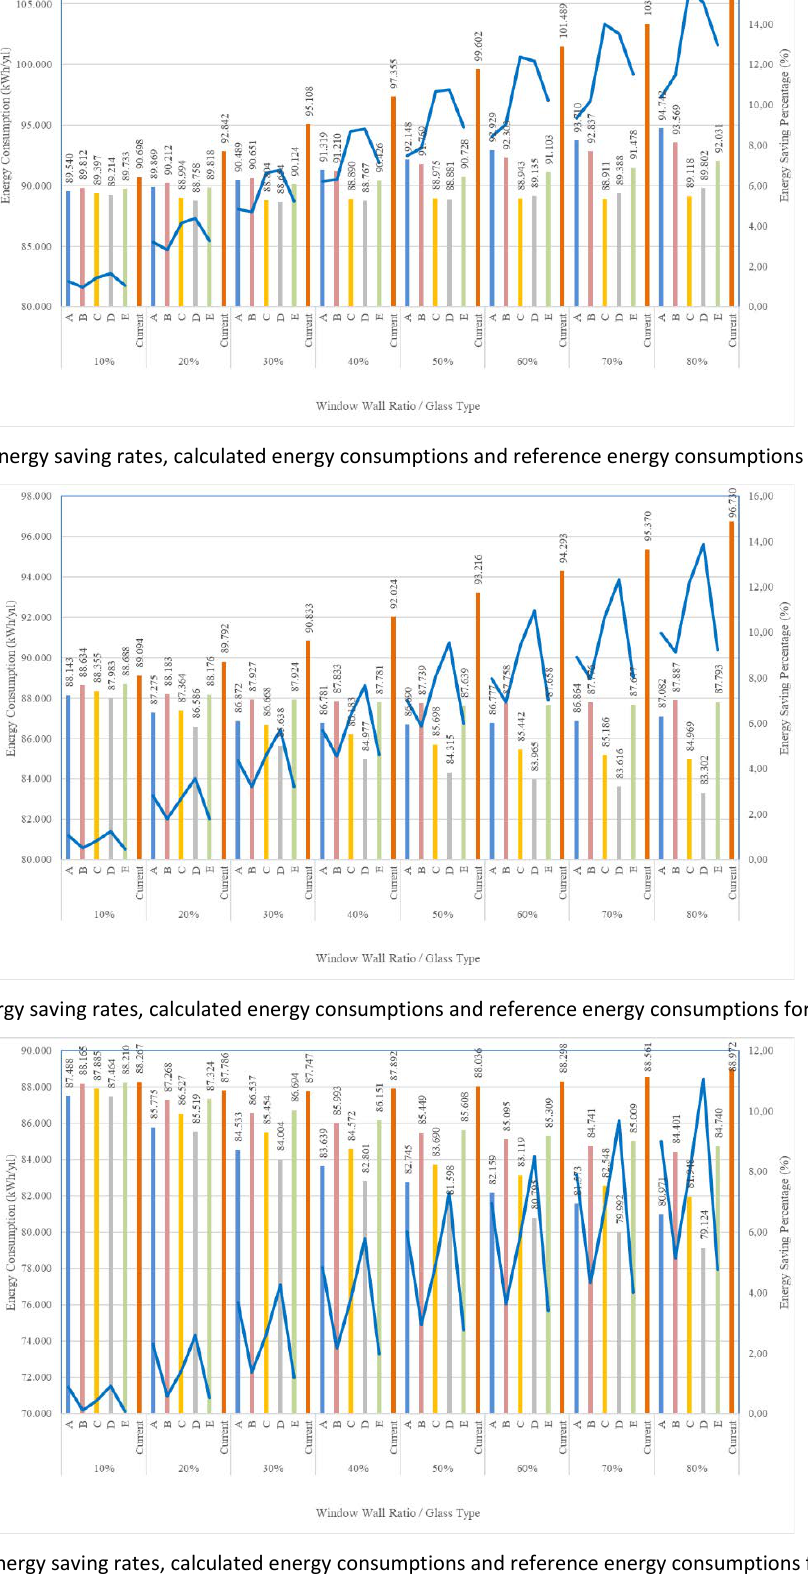
Figure 13 Energy saving rates, calculated energy consumptions and reference energy consumptions for